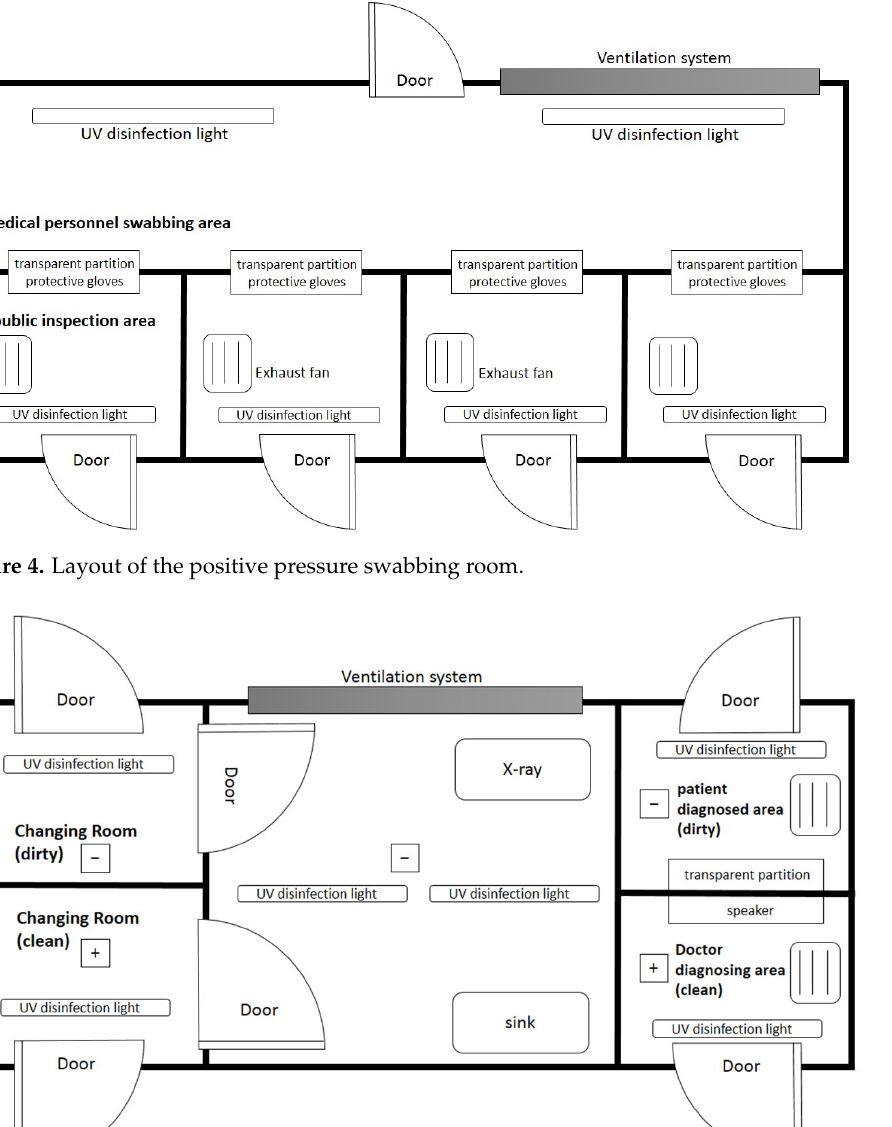
Figure 5. Layout of the fever clinic.